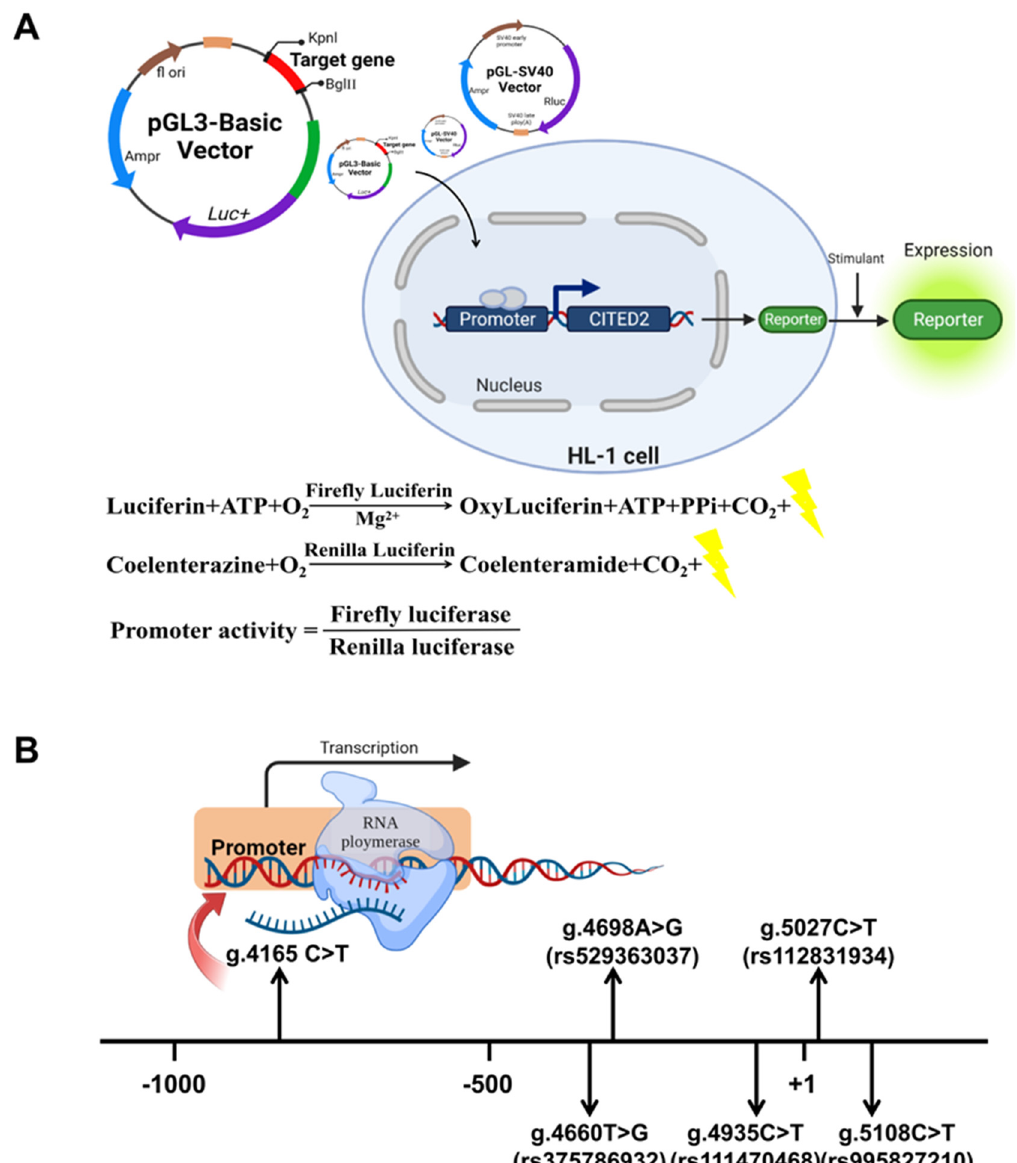
Figure 2. Relative transcriptional activity of the CITED2 gene promoter. ( A ) Procedure of cell function experiments. To confirm the effect of variants on promoter activity, wild-type and CITED2 gene promoter fragments with variants were prepared, gene expression vectors were constructed, and mouse cardiomyocyte (HL-1) cells were transfected. The transcriptional activity of wild-type and CITED2 gene promoters with variants was detected by a dual-luciferase reporter assay. ( B ) Regulatory variants of the CITED2 gene. The transcription start point is located at position 5001 of the first exon (+1), and these genetic variants are named according to the genomic sequence of the human CITED2 gene (Genbank Accession No. NG_016169.1), describing the location of the CITED2 gene promoter variants.